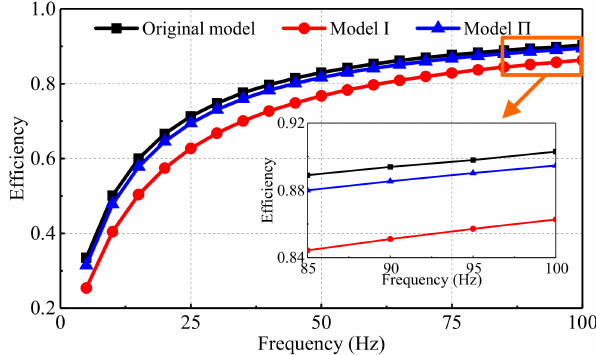
Figure 22. Efficiency versus